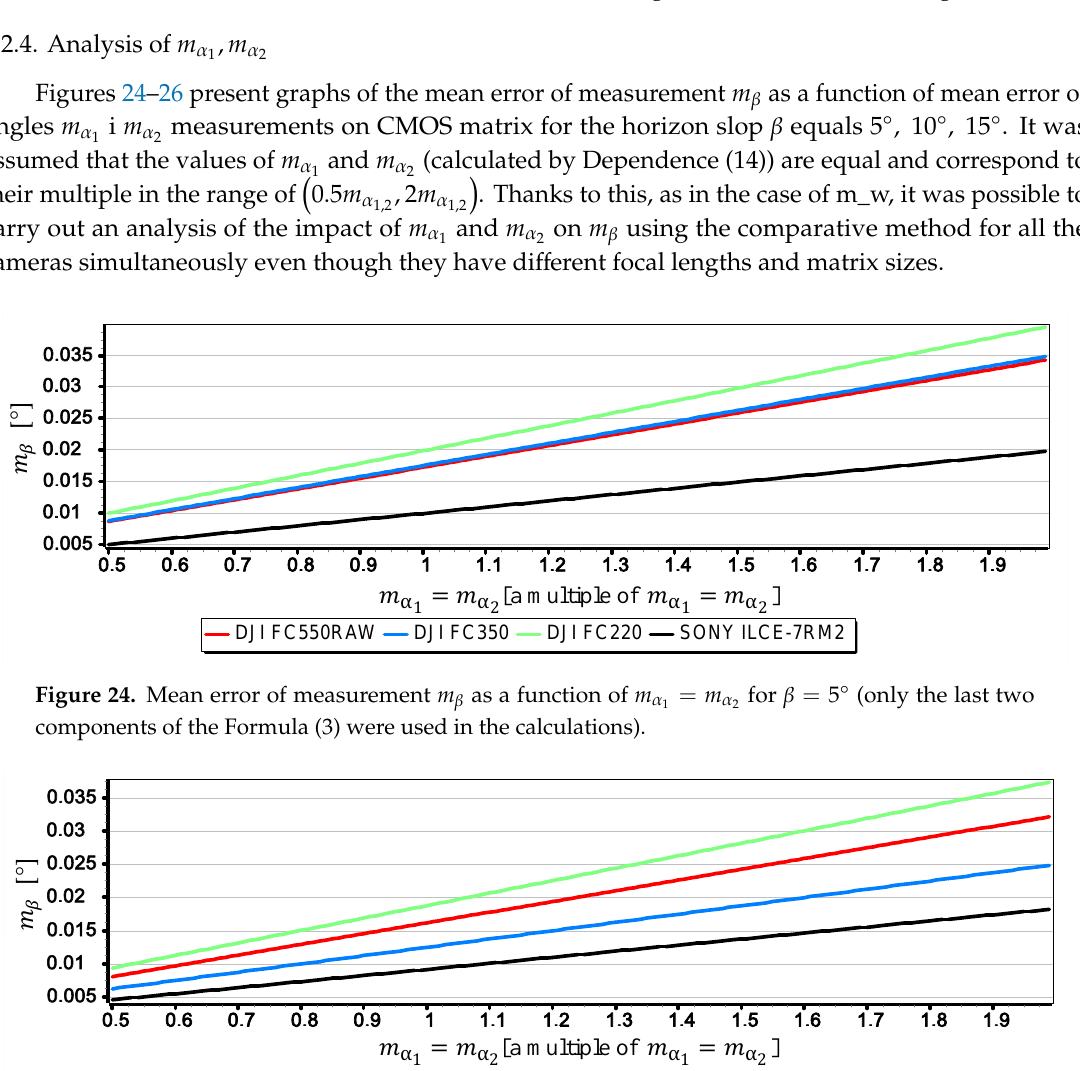
Figure 25. Mean error of measurement 𝑚 𝛽 as a function of 𝑚 α two components of the Formula (3) were used in the calculations).